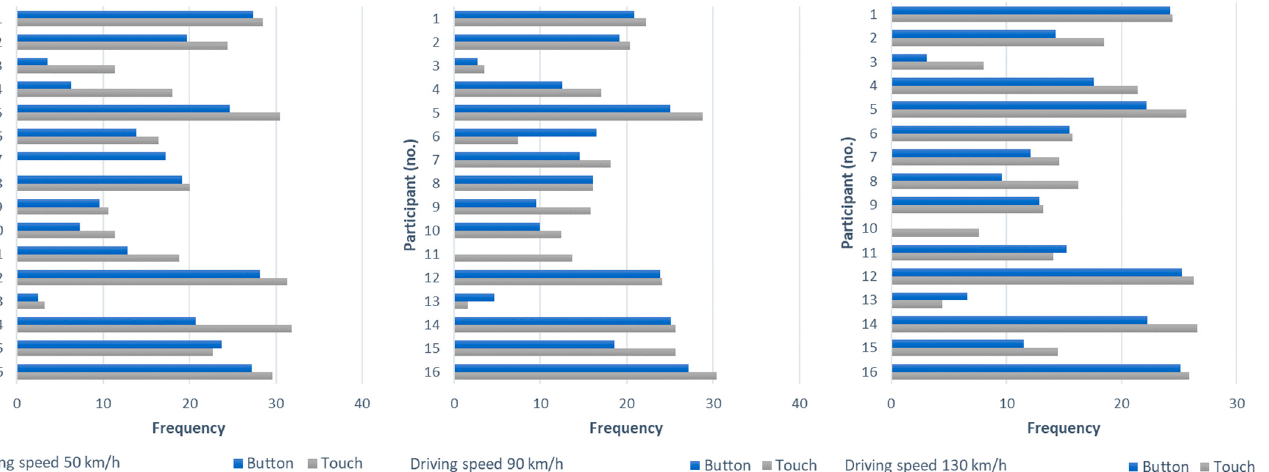
Table 8. The level of cognitive load based on saccade frequency: T ≥ B → 1; T < B → –1 (red). 1